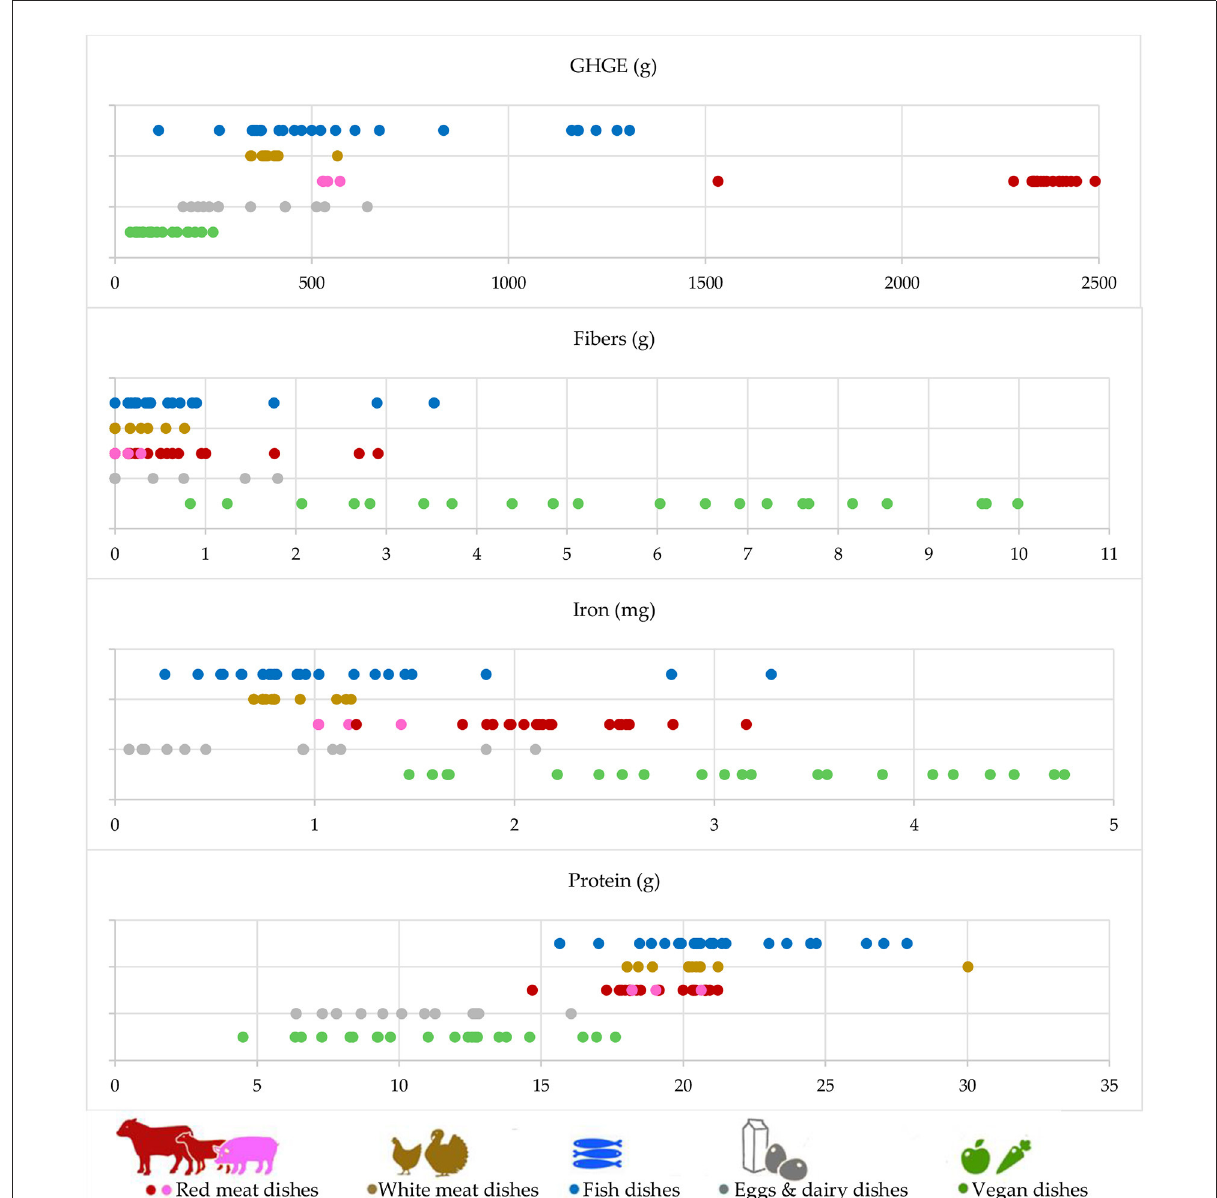
FIGURE2 GHGE (grams of CO 2eq ) and some nutrients and minerals associated with the second-course dishes considered in the recipe book (excluding dishes with processed meat). Eggs and dairy dishes can be offered on the vegetarian and omnivorous menus, meat, and fish dishes can be offered only on the omnivorous